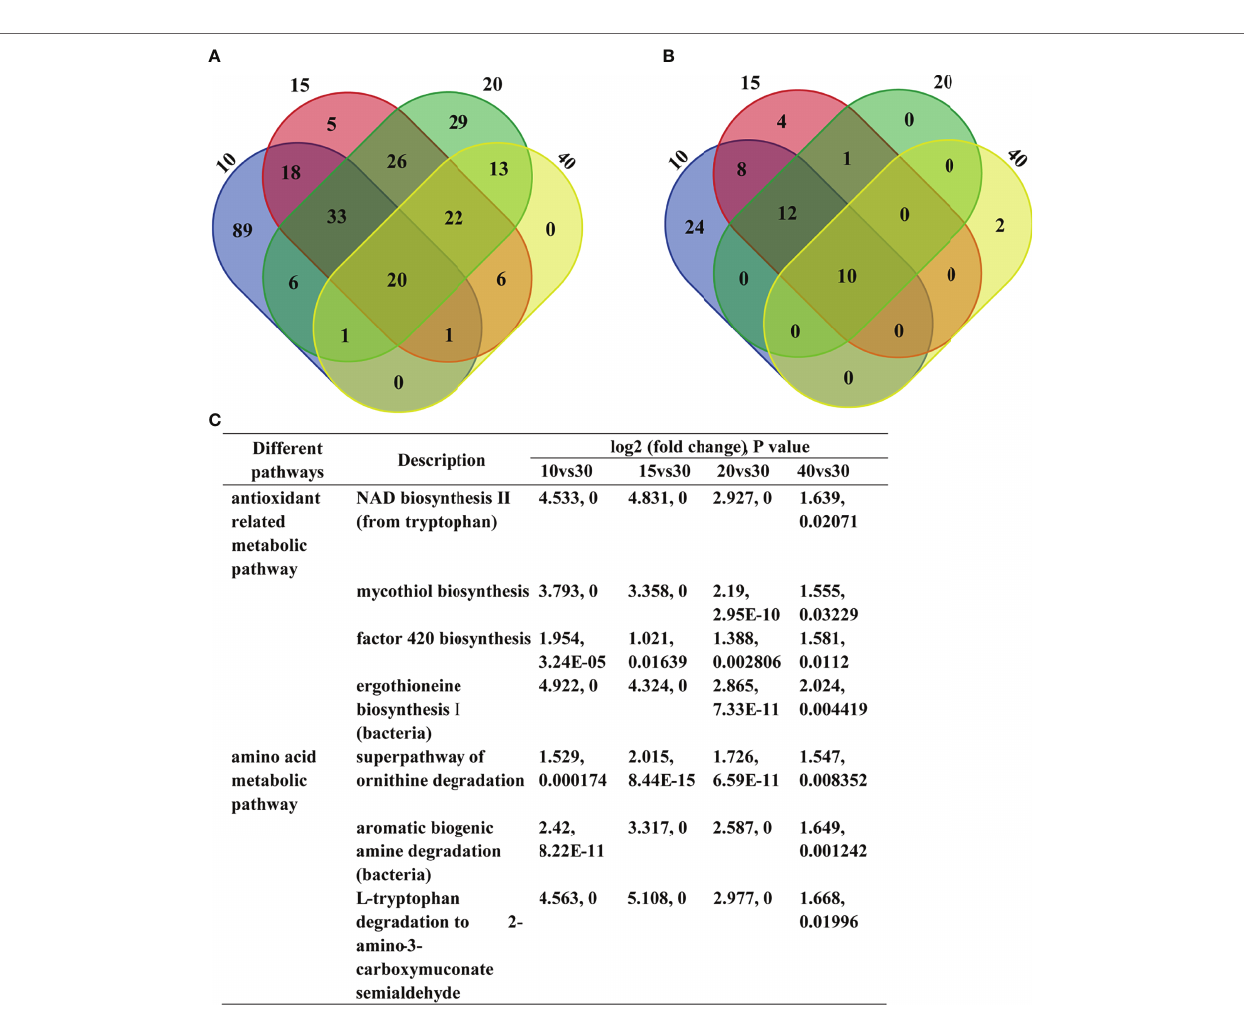
FIGURE 6 | Changes of U. unicinctus intestine microbial function in different salinity groups. (A) Venn diagram showing the overlap between the up-regulated KEGG pathways in different salinity groups compare to 30‰ group ( P < 0.05). (B) Venn diagram showing the overlap between the down-regulated KEGG pathways in different salinity groups compare to 30‰ group ( P < 0.05). (C) Antioxidant related metabolic pathways and amino acid metabolic pathways in different salinity groups compare to 30‰